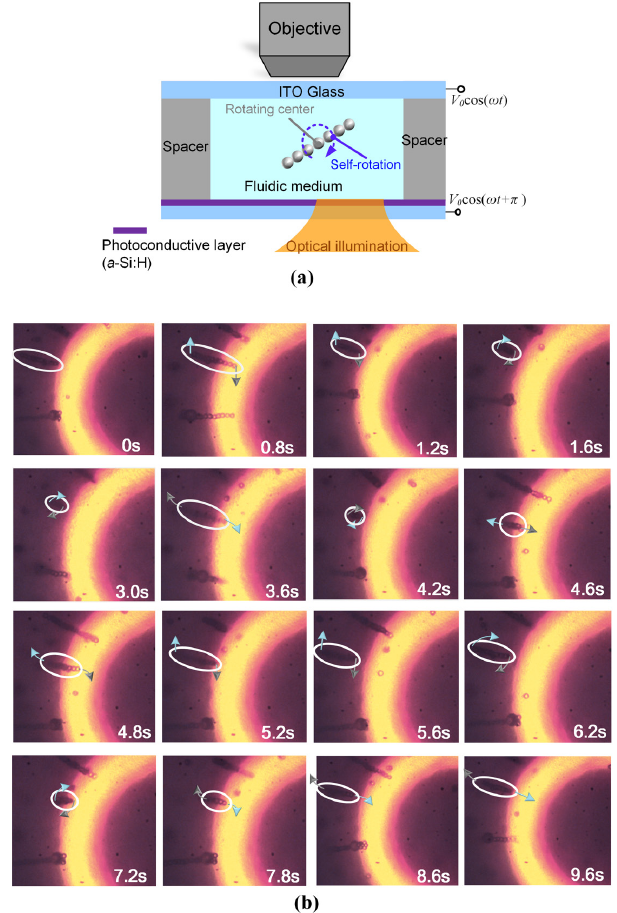
Figure 7. Self-rotation of chains of particles with a diameter of 4 μm in their pitch axes by the rotating electric field at 700 kHz. ( a ) Schematic description of the self-rotation of a chain of particles in OET device. ( b ) Experimental snapshots of movement of particle chains at a series of time instants. The time unit is second (s).